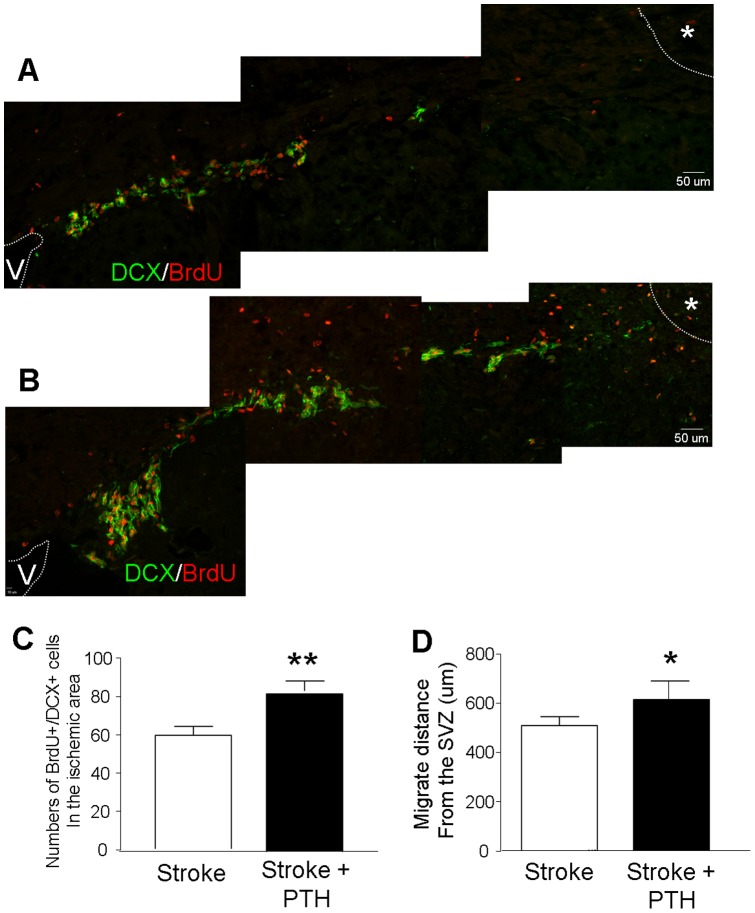
PTH treatment enhanced neuroblast migration from the SVZ to the ischemic cortex.The neuroblast migration and regenerative activity along the ipsilateral SVZ to ischemic cortex migration route was examined by immunostaining of migrating neural progenitor marker DCX (green) and the proliferating marker BrdU (red) 6 days after the onset of ischemia. A. In the post ischemic brain there was significant neuroblast migration from the SVZ to the ischemic barrel cortex (*). Noticeably more DCX and BudU positive cells can be seen in the migration path of PTH treated animals (B) than in the stroke/saline brain (A). C. The total number of DCX+/BrdU+ cells in six sections per animal was counted under a fluorescent microscope. Double-labeling of DCX/BrdU in white matter of ischemic stroke-saline (C) and PTH treated mice (D) 6 days after ischemia. PTH treatment promoted more DCX/BrdU-positive cells moving toward the ischemic cortex (F). The number of DCX+/BrdU+ cells in stroke control and stroke/PTH groups. PTH treatment markedly augmented the proliferating activity among DCX+ cells. D. PTH treatment increased the average migration distance from the SVZ toward the ischemic barrel cortex. N = 6 in stroke/saline group and 7 in stroke/PTH group; * P<0.05 vs. stroke controls, ** P<0.01 vs. stroke controls.